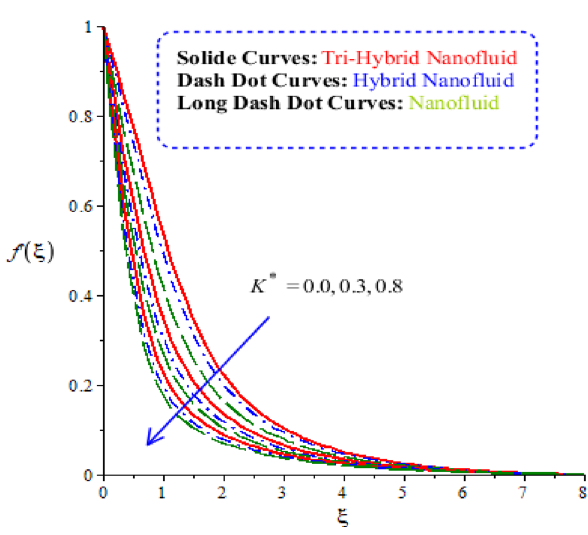
Figure 5. Comparative variation of velocity curves among nanoparticles versus K ∗